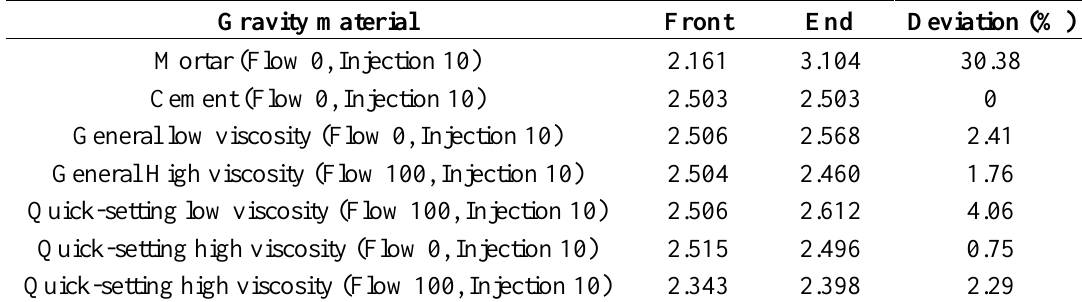
Table 5. Specific gravity